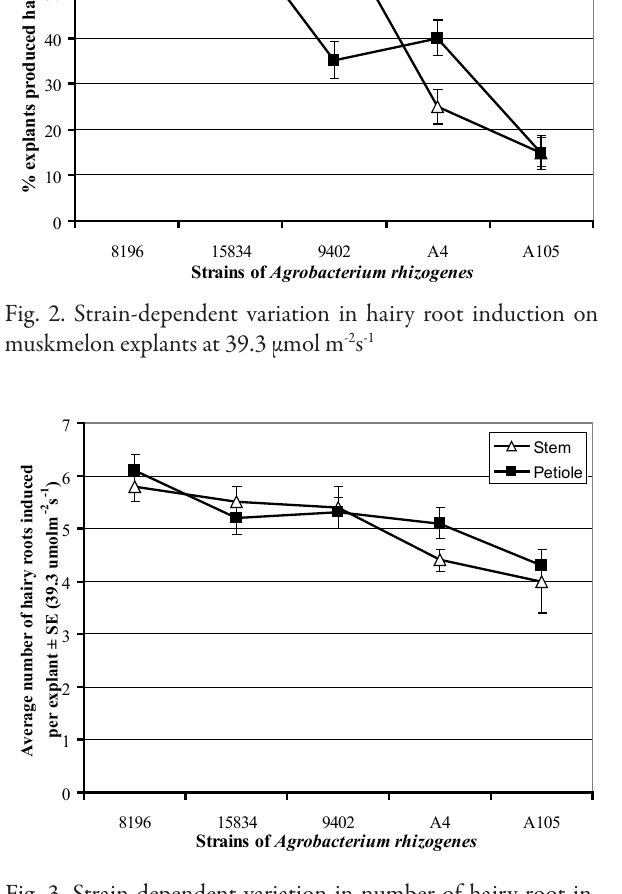
Fig. 3. Strain-dependent variation in number of hairy root in- duction on muskmelon explants